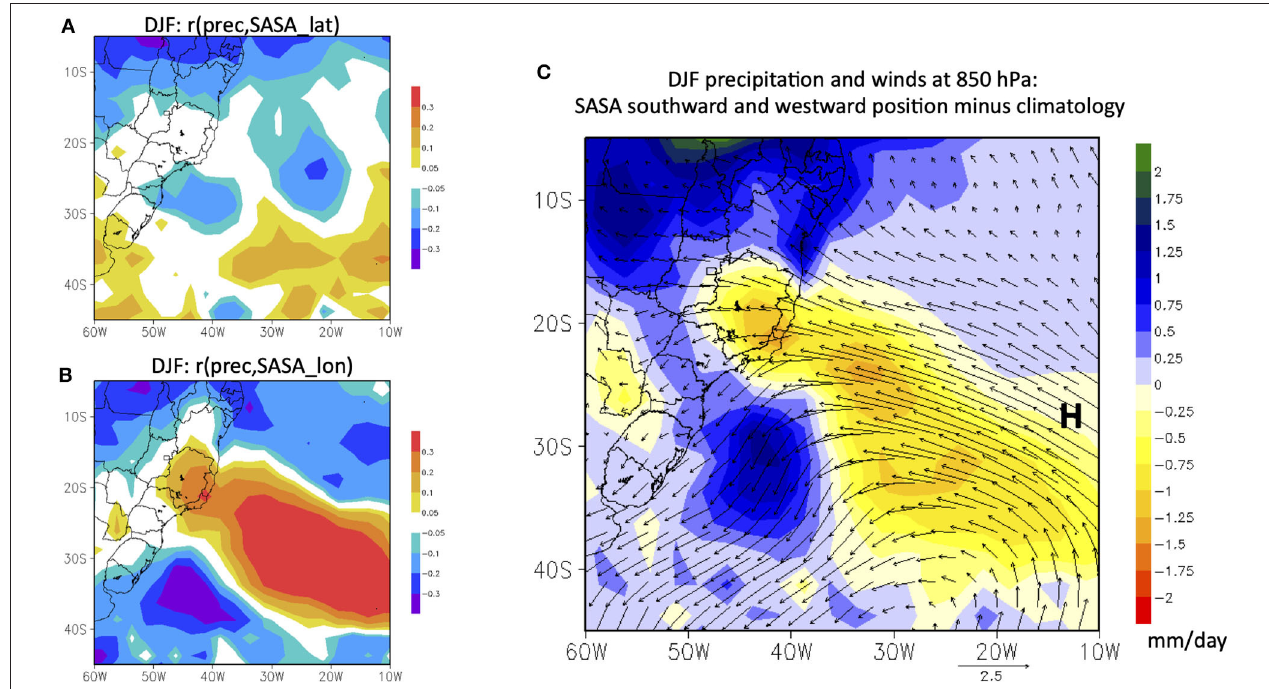
FIGURE 7 | (A) Linear correlation between monthly precipitation and SASA latitude in austral summer months (DJF) from 1979 to 2019; (B) the same as (A) but for SASA longitude and (C) anomaly of the monthly precipitation (mm/day) and wind direction at 850 hPa considering, concomitantly, the most southward and westward position of the SASA in relation to the DJF climatology